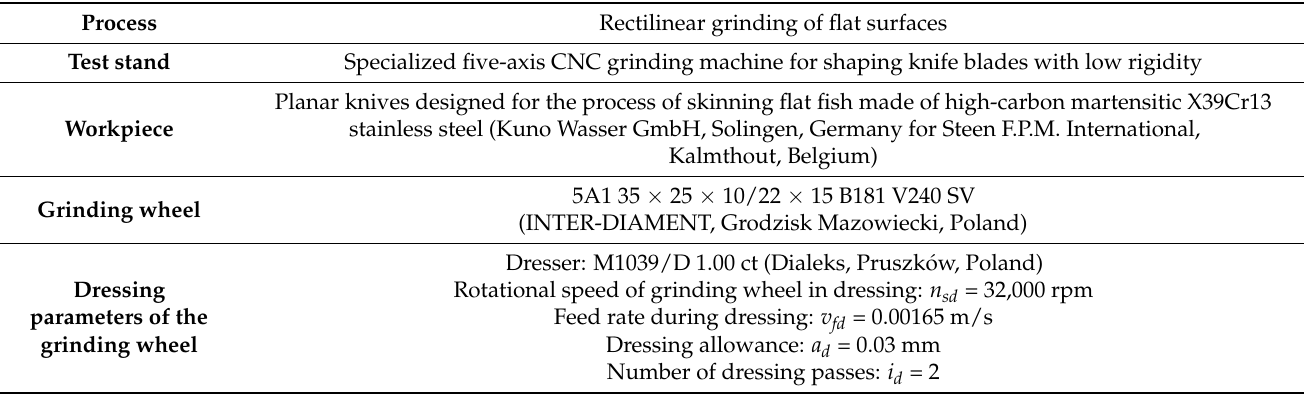
Table 2. Specification of parameters and conditions of experimental studies. Rectilinear grinding of flat